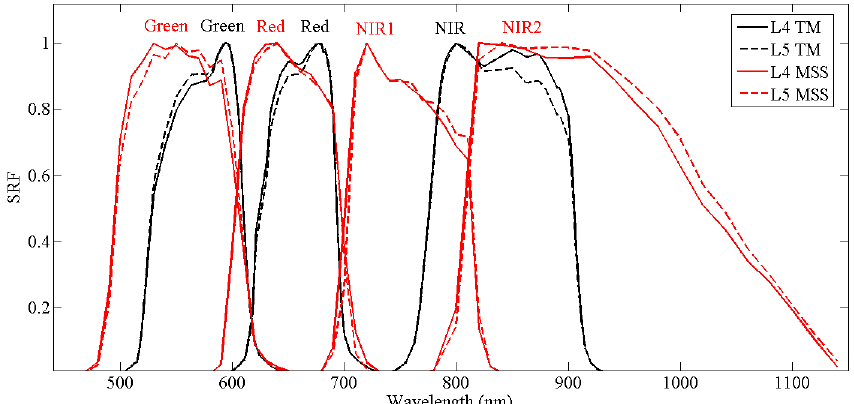
Figure 1. Spectral response functions (SRFs) for the MSS multispectral channels and the approximately corresponding TM channels onboard Landsat 4 (L4) and Landsat 5 (L5), including the channels located within Green, Red, and near-infrared (NIR) regions respectively. Additional channels of the TM (Table 1) are not shown in this figure. The data were obtained from https://landsat.gsfc.nasa.gov.